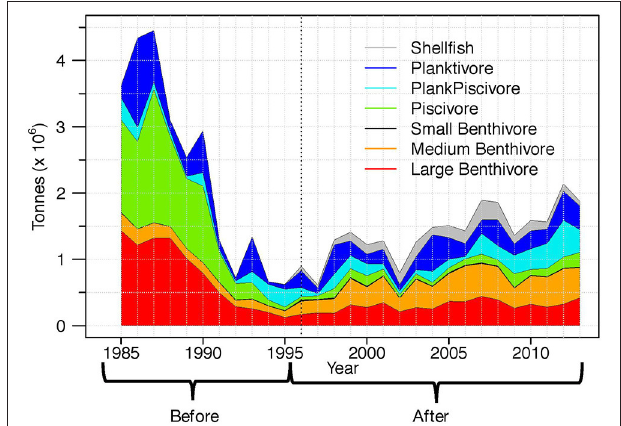
FIGURE 2 | Fish functional group biomass in NAFO division 3LNO, illustrating the collapse of total biomass and changing structure of the community. All functional groups except shellfish are included as response variables. The Before period is from 1985 to 1995, the After period is from 1996 to 2013, and the Full period includes 1985–2013 (Before +